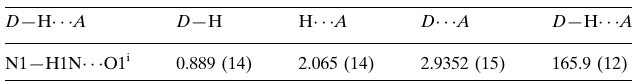
Hydrogen-bond geometry (A˚ , (cid:2)